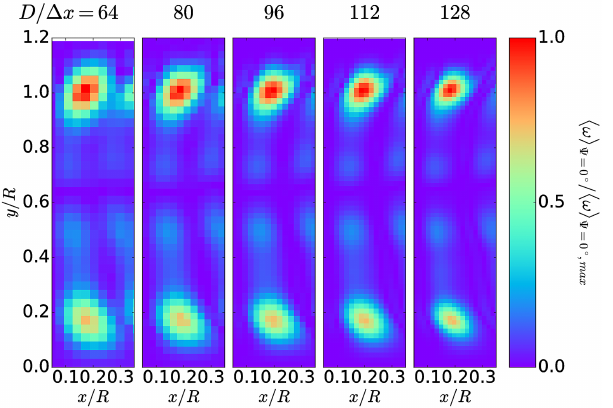
Figure 9. Normalized vorticity (cid:104) ω (cid:105) (cid:57) = 0 ◦ / (cid:104) ω (cid:105) (cid:57) = 0 ◦ , max in the near wake for different grid